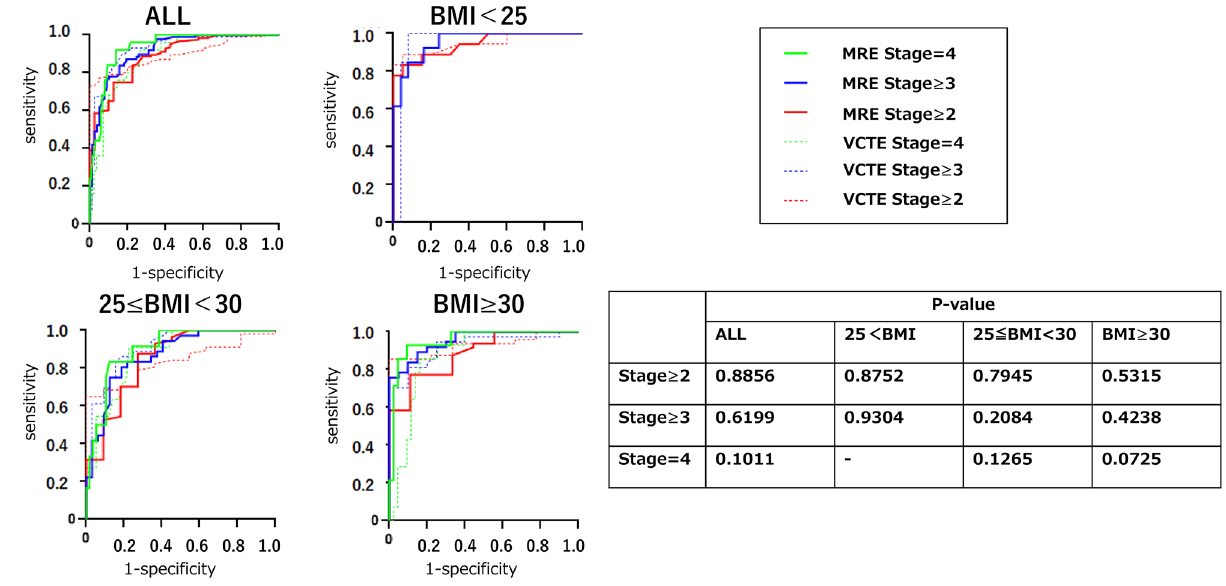
Figure 3. Specific cut-offs to define each grade of steatosis and stage of fibrosis by VCTE and MRI/MRE techniques. MRE magnetic resonance elastography, MRI magnetic resonance imaging, VCTE vibration- controlled transient elastography.